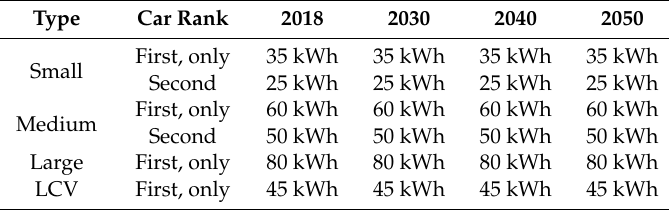
Table A3. Battery capacity of the battery electric vehicle.